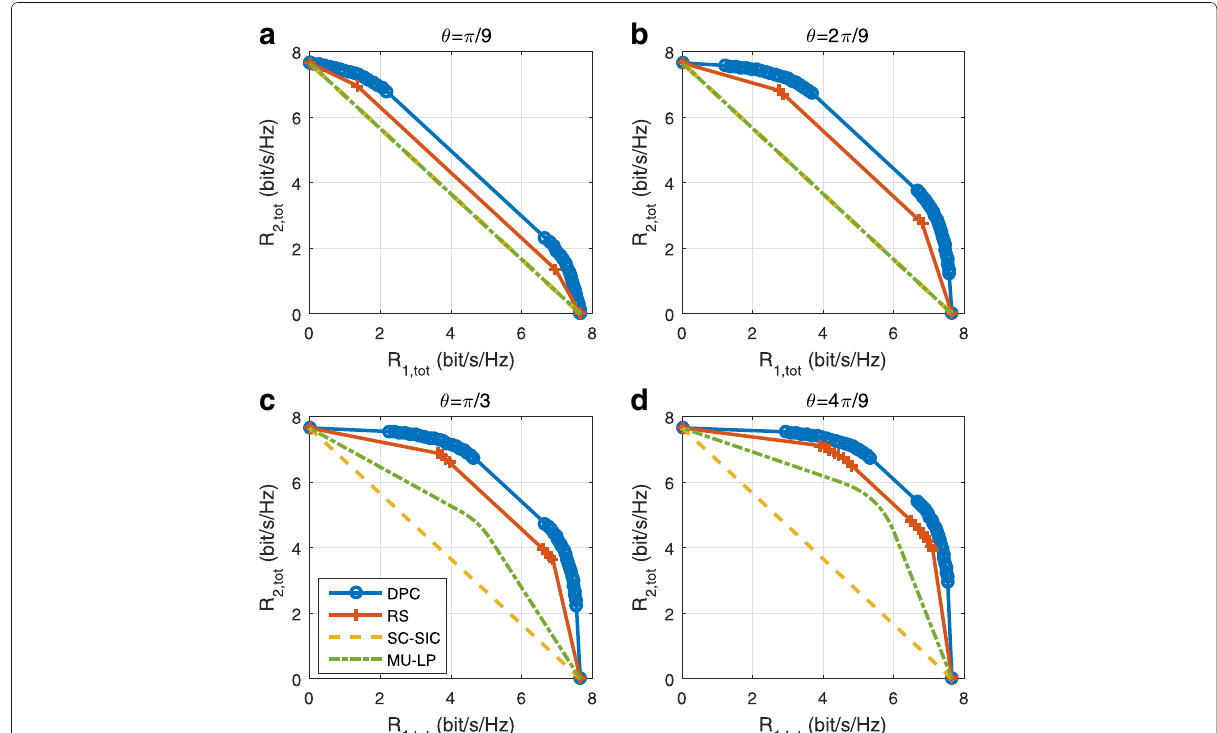
Fig. 8 Achievable rate region comparison of different strategies in underloaded two-user deployment with perfect CSIT, γ = 1 and N t = 2, SNR = 20 dB. a θ = π/ 9. b θ = 2 π/ 9. c θ = π/ 3. d θ = 4 π/